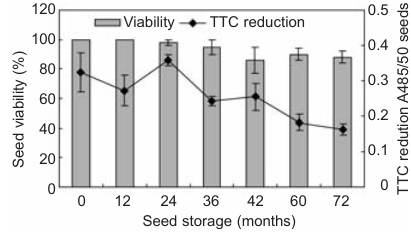
Figure 1. Storage-dependent changes in seed viability of H. niger . Data are average of 3 measurements each ± s.d.